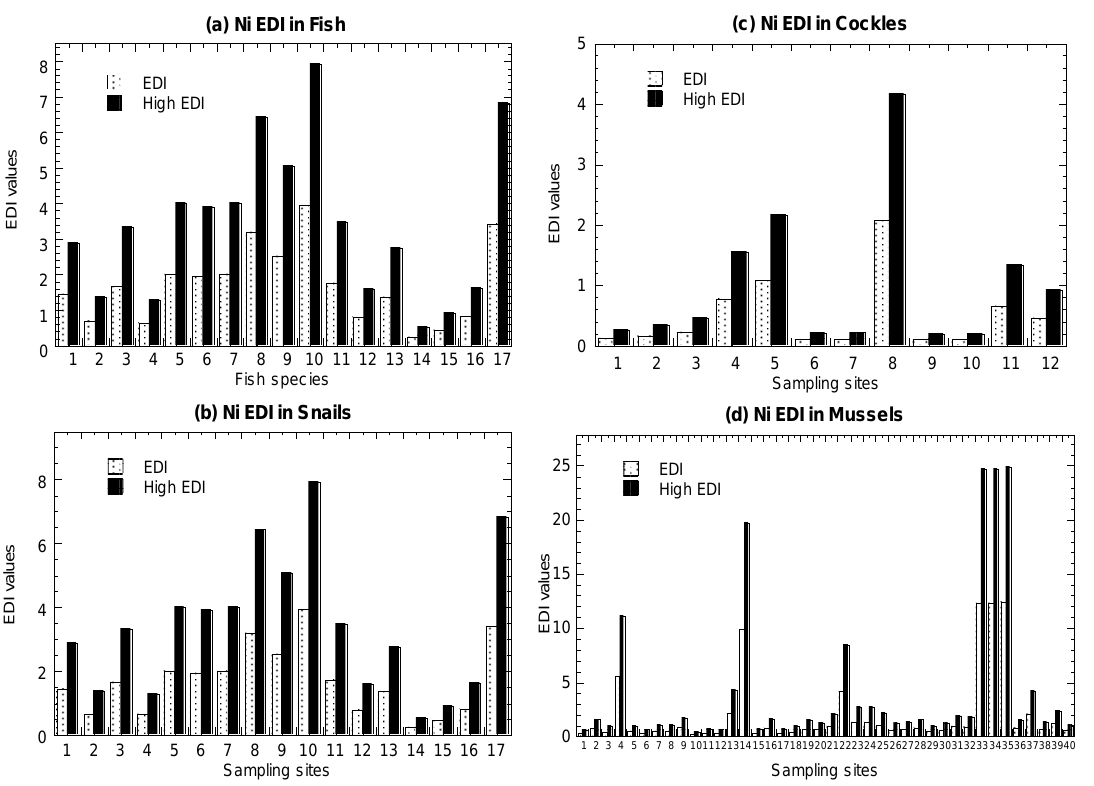
Figure 3. Values of average-level estimated daily intake (EDI) and high-level estimated daily intake (High EDI) of nickel (Ni) in the ( a ) marine fish (1–19), ( b ) mangrove snail Cerithidea obtusa (1–17), ( c ) cockle Anadara granosa (1–12), and ( d ) marine mussel Perna viridis (1–40) cited from Yap et al. [35]. Note: The nickel oral reference dose = 20 µg/kg/day [64]. The high-level consumers (2 times the consumption rate of average-level consumers) are indicated by High.